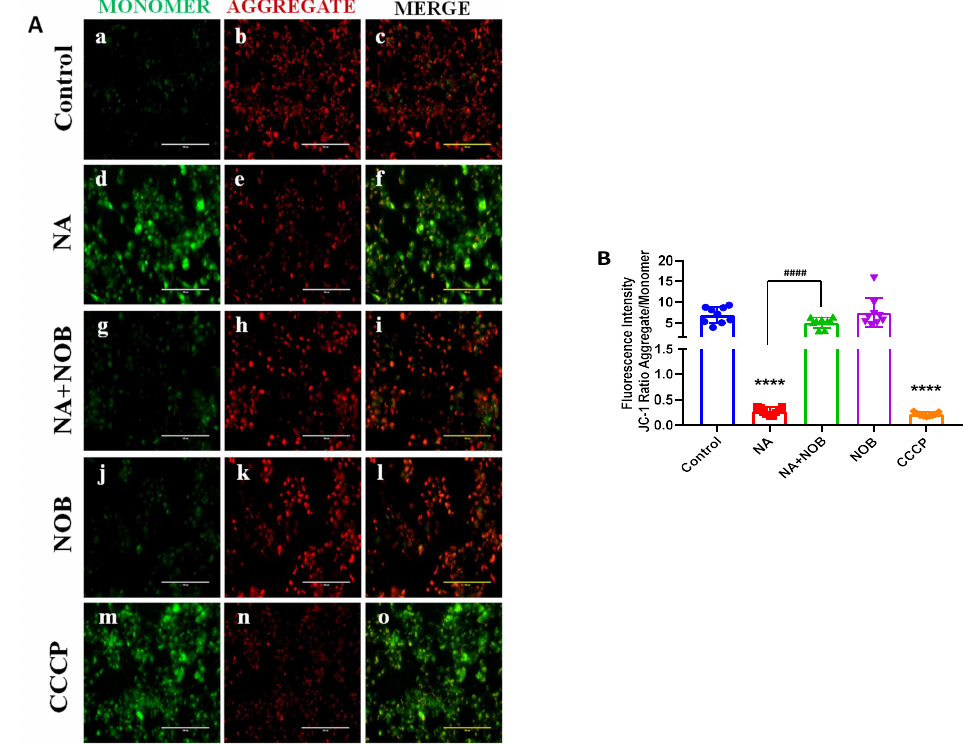
Figure 4. Mitochondrial membrane potential (MMP) measurement by JC1 dye in ( A ). ( c ) Control or unexposed cells, ( f ) NA-exposed cells, ( i ) NA + NOB co-exposed group, ( l ) NOB exposed cells, and ( o ) Positive control group exposed to CCCP. The JC1 aggregates were observed to be red and monomers to be green. Images were taken with an Invitrogen EVOS FL fluorescence microscope. Scale bar, 100 µ M. ( B ) Fluorescent intensity was calculated by ImageJ software; images are represented in graph format. Data are presented as the ± SEM of three separate experiments performed in n = 3 (biological replicates). The change in expression pattern is statistically significant as indicated by **** p < 0.0001 in comparison to the control and #### p < 0.0001 compared with NA-exposed